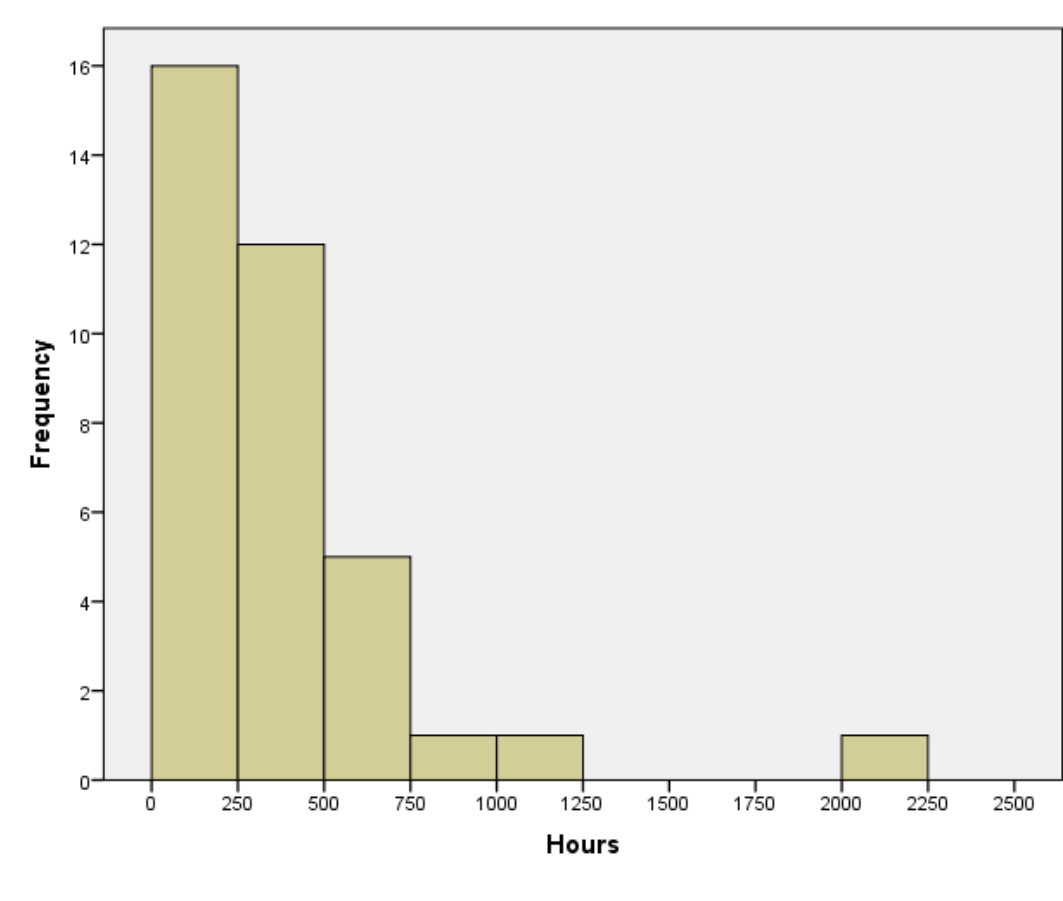
Figure 1. Student estimated time (hours) spent working on their dissertation.